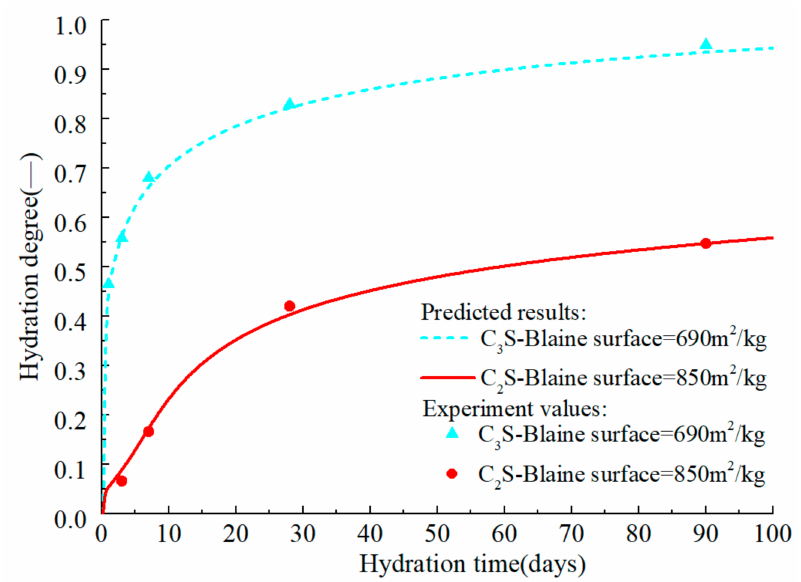
Figure 11. Measured values and prediction curves of long-term hydration degree of C 2 S and C 3